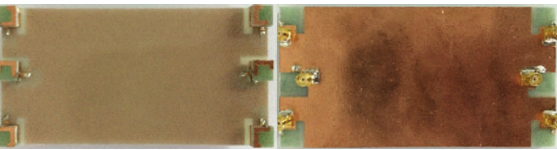
Figure 17: Photograph of the fabricated MIMO antenna system.